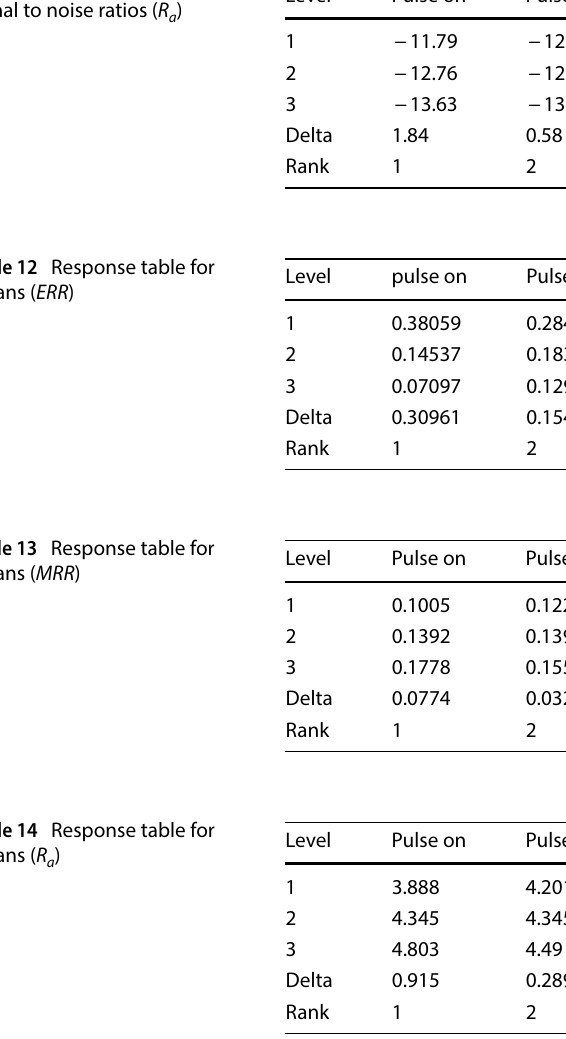
Table 11 Response table for signal to noise ratios ( R